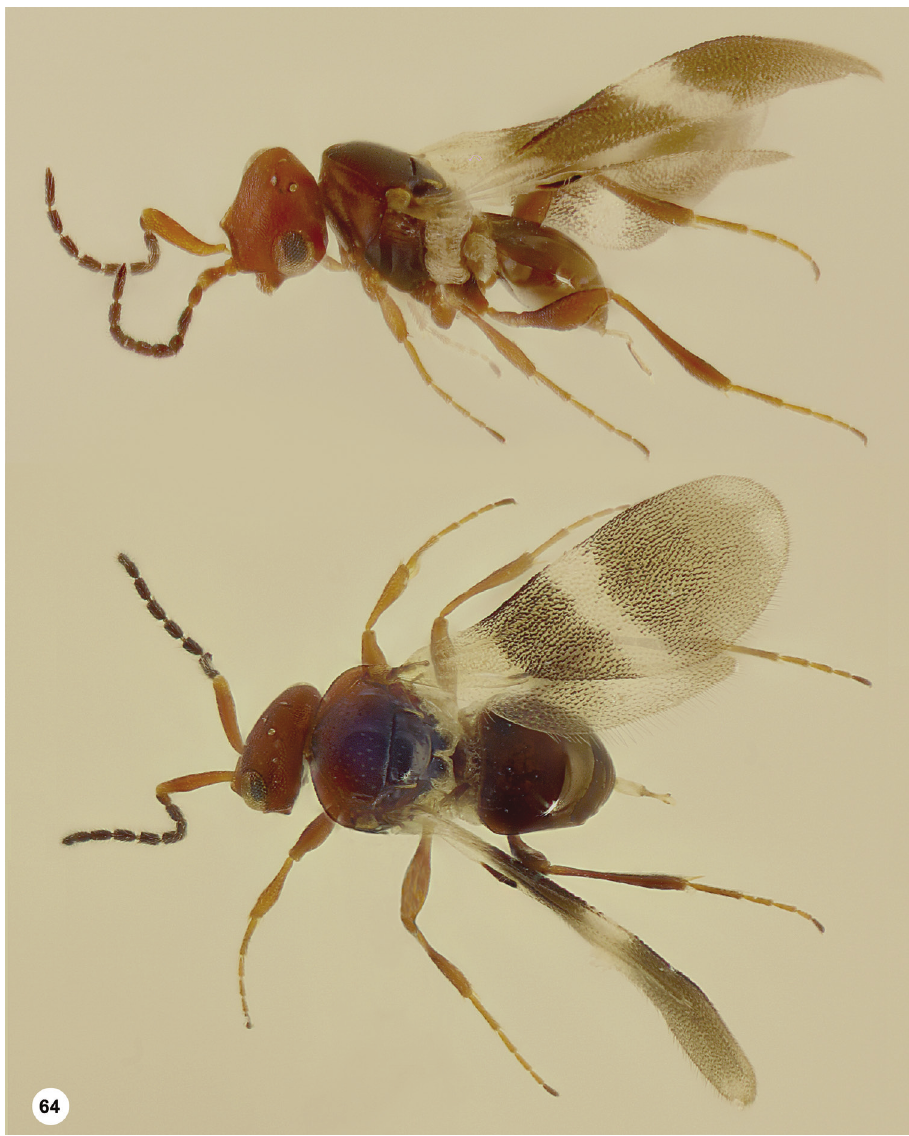
Figures 64. Pulchrisolia valerieae, male holotype (BMNH 010823075) 64 head, mesosoma, metasoma, lateral view (top), dorsal view